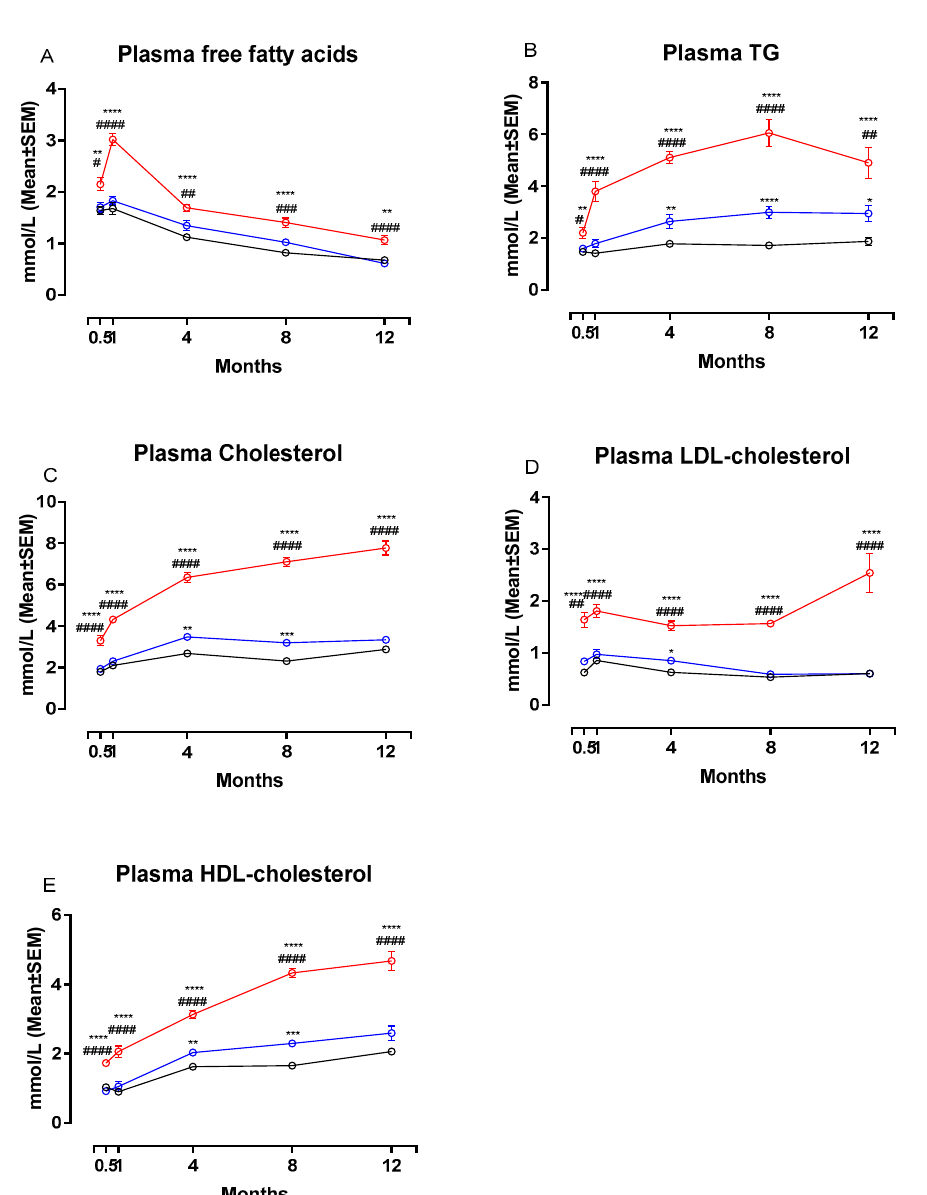
Figure 3. Effects of the NASH diet on lipid parameters in Syrian hamsters fed either NASH, or one of the two control diets during the study period. Effects of the NASH-diet on plasma concentrations of FFA ( A ), triglycerides ( B ) and cholesterol in different lipoprotein fractions ( C – E ) during the study period. Black circles and lines indicate data from chow-fed hamsters. Blue circles and lines indicate data from CTRL-fed hamsters. Red circles and lines indicate data from NASH-fed hamsters. Superscripts *, **, ***, **** indicate p < 0.05, p < 0.01, p < 0.001, p < 0.0001 compared to chow. Superscripts #, ##, ###, #### indicate p < 0.05, p < 0.01, p < 0.001, p < 0.0001 compared to CTRL. FFA: free fatty acid, TG: triglyceride, LDL: Low-density-lipoprotein, HDL: High-density